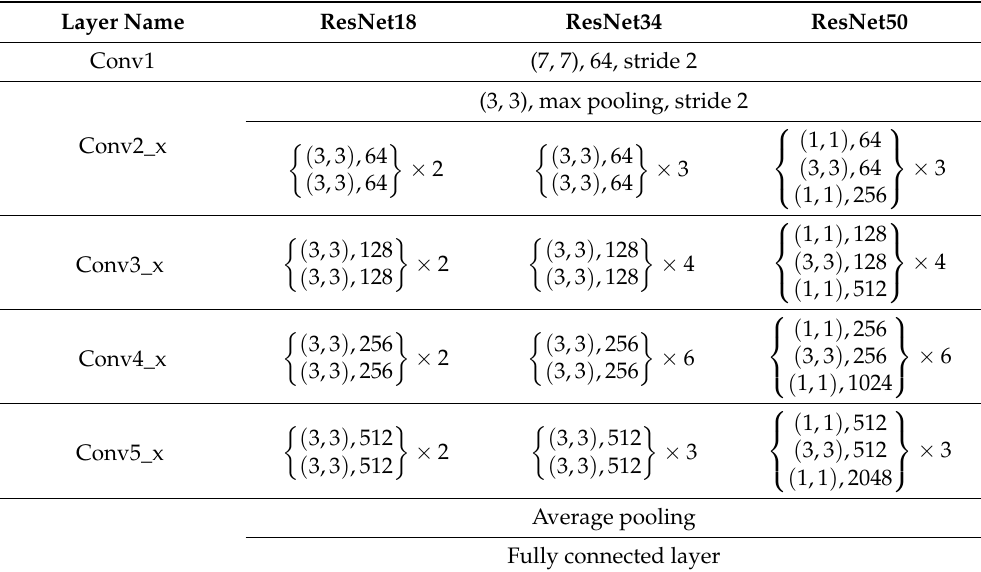
Table 1. The structure of ResNet18, ResNet34, and ResNet50